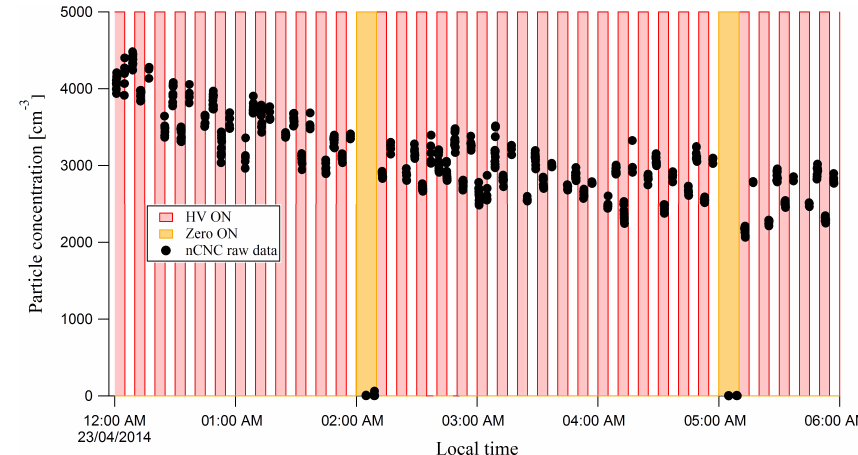
Figure 13. Time series of particle concentration measured in Hyytiälä, Finland, with the nCNC and new inlet system. The red background (HV ON) color indicates the time when the ion filter in the inlet system is on. The yellow background (ZERO ON) color indicates the time when the automatic background concentration measurement is conducted. Changes in the concentration measured by the nCNC can be attributed to the removal of ions from the sample flow when the ion filter is on and the measurement of particle-free air when the background concentration is